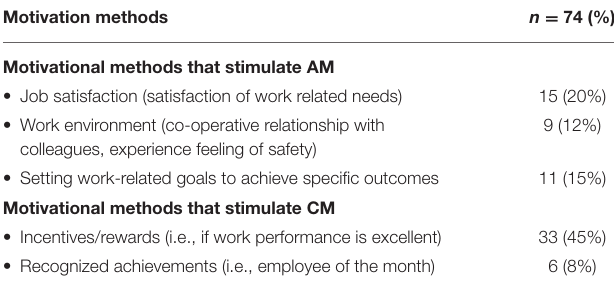
TABLE 2 | Motivational methods perceived to be the most effective.